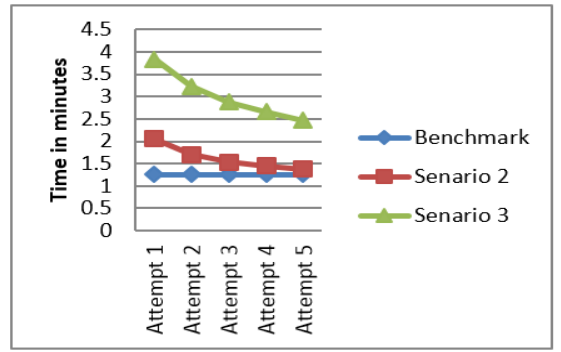
Figure 7. Variance of benchmark and all sce- narios